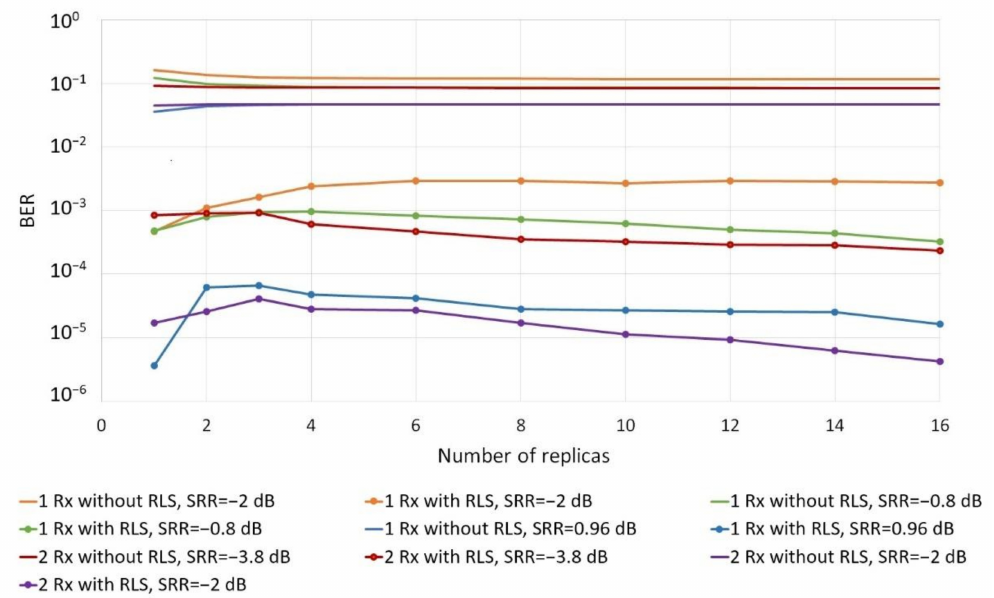
Figure 6. Comparison of the reception quality as a function of the number of replicas at SNR = 30